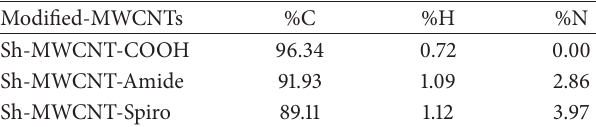
Table 1: Elemental analysis of modified